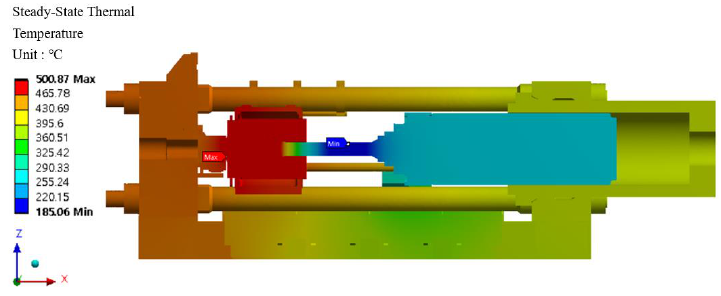
Figure 26. Results of the steady-state heat transfer analysis at 400 °C.